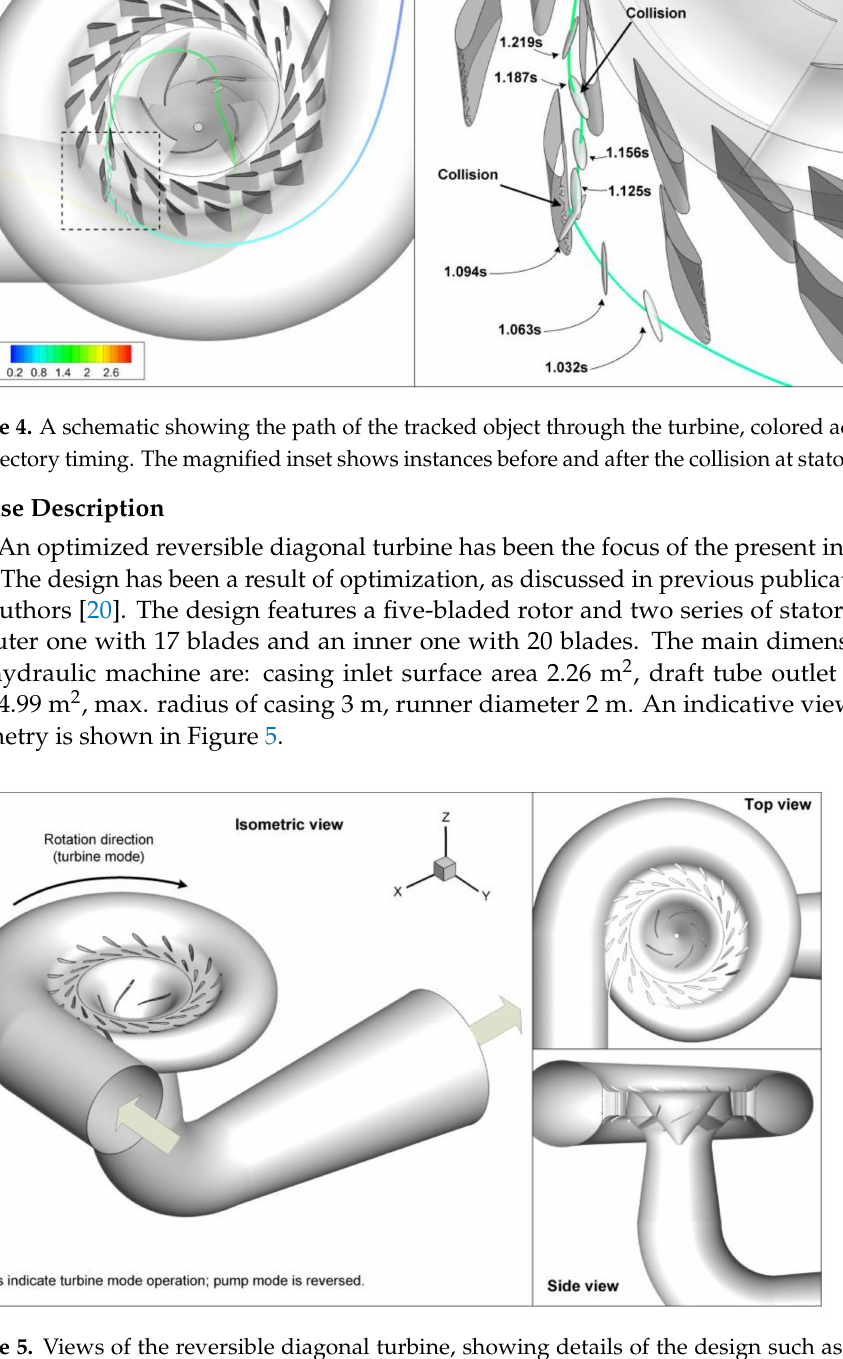
Figure 5. Views of the reversible diagonal turbine, showing details of the design such as the two rows of stator blades, the five-bladed runner and the draft